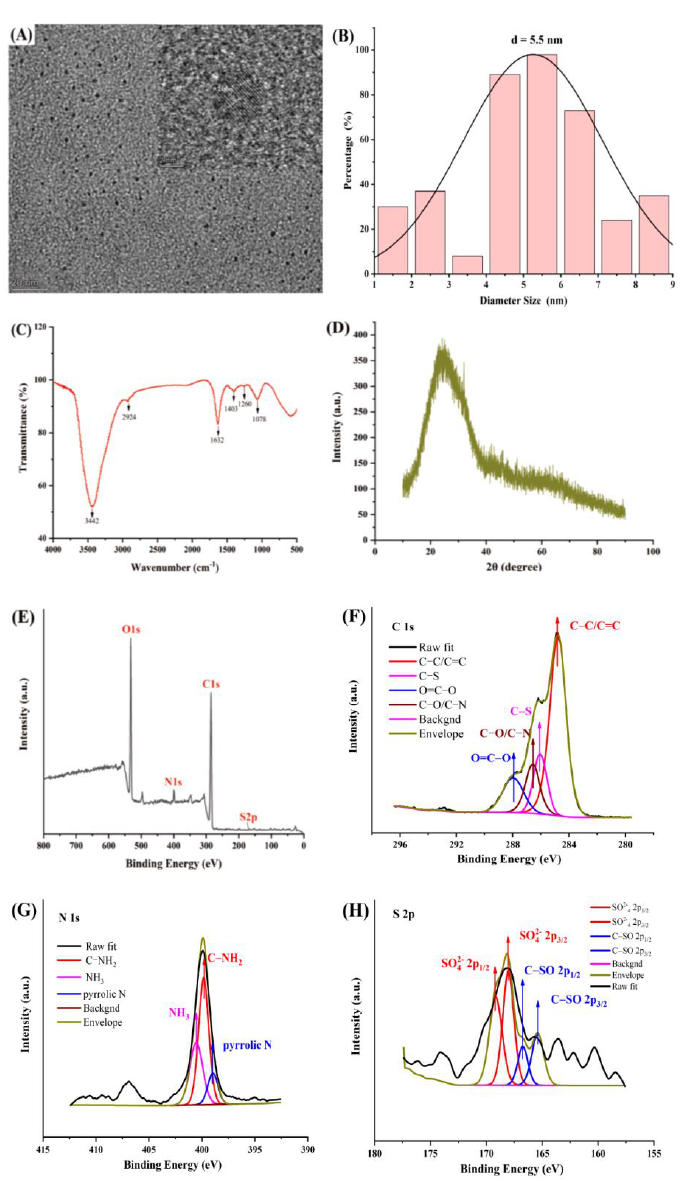
Figure 1. ( A ) TEM images of CQDs, insert: high-resolution TEM images of CQDs. ( B ) The size distribution histogram of CQDs. ( C ) FT − IR of CQDs. ( D ) XRD of CQDs. ( E ) XPS of CQDs. ( F – H ) High-resolution spectra of C 1s , N 1s , and S 2p for the CQDs.